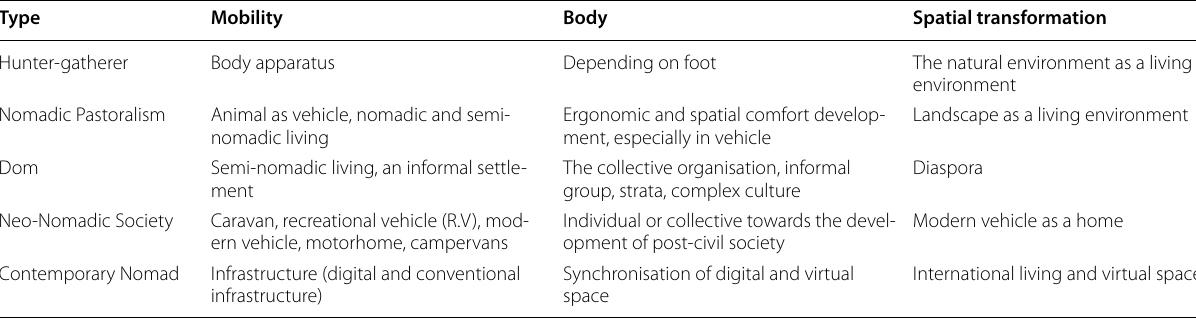
Table 3 Nomadic spatial transformation